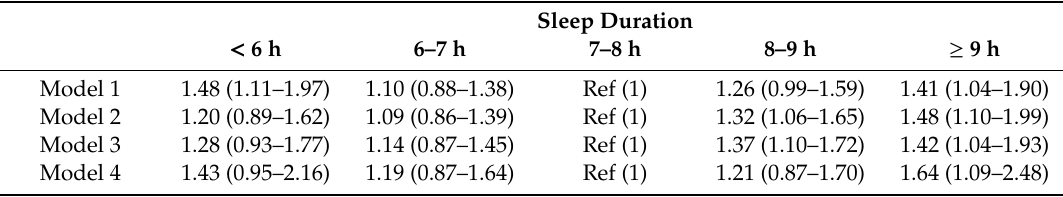
Table 2. Odds ratio and 95% confidence intervals for higher high-sensitivity C-reactive protein ( > 2.0 mg / L) according to sleep duration.